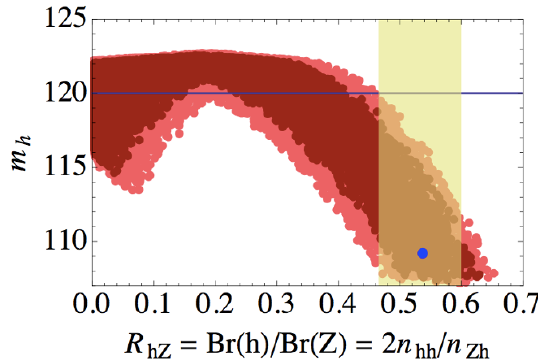
Figure 8 . MSSM Higgs mass as a function of R hZ . The horizontal blue line denotes m h = 120 GeV, the cuto(cid:11) below which the Higgs mass is taken to be inconsistent with the MSSM. Light (dark) red bands correspond to 440 (cid:20) m ~ (cid:20) 520 GeV and 930 (cid:20) m ~ (cid:20) 1030 GeV (450 (cid:20) m ~ (cid:20) 510 GeV and t 1 t 2 t 1 945 (cid:20) m ~ (cid:20) 1015 GeV). The blue dot denotes the benchmark point in our analysis. The t 2